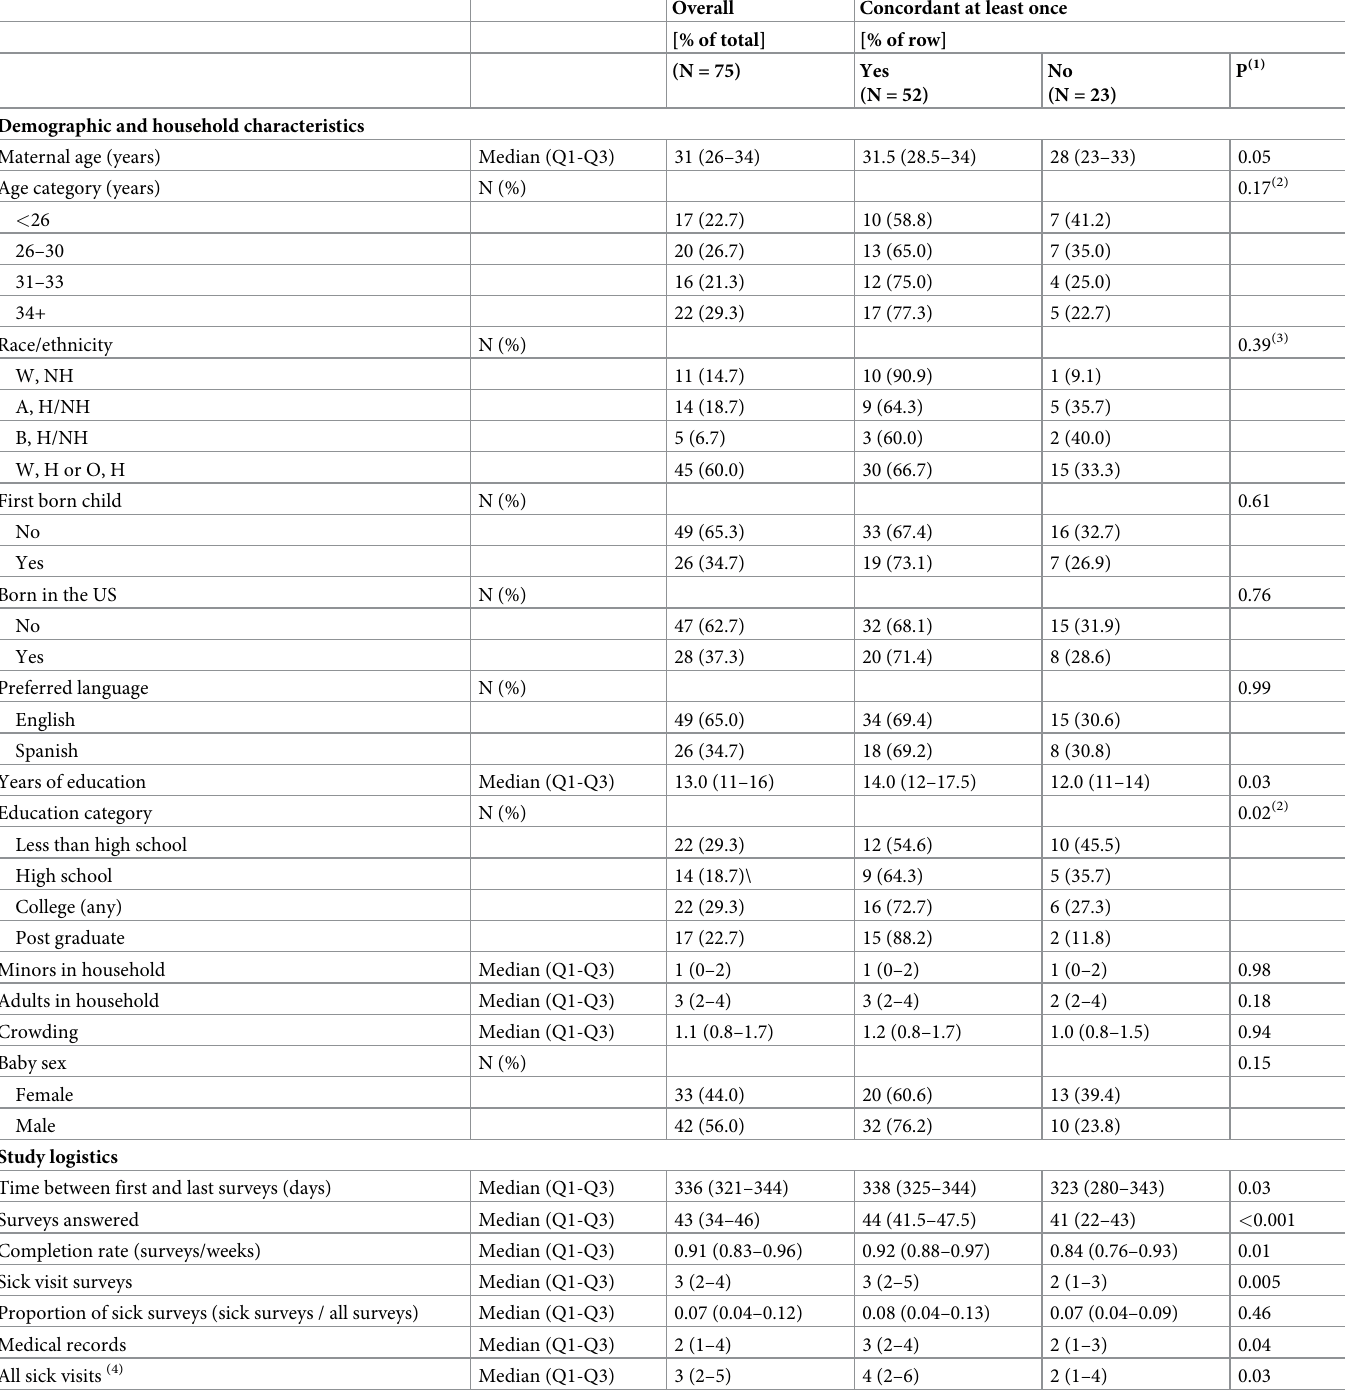
Table 3. Demographic and household characteristics and study logistics, for mothers overall and with and without at least one concordant visit/report pair. Num- bers presented are N (%) unless otherwise indicated. Overall Concordant at least